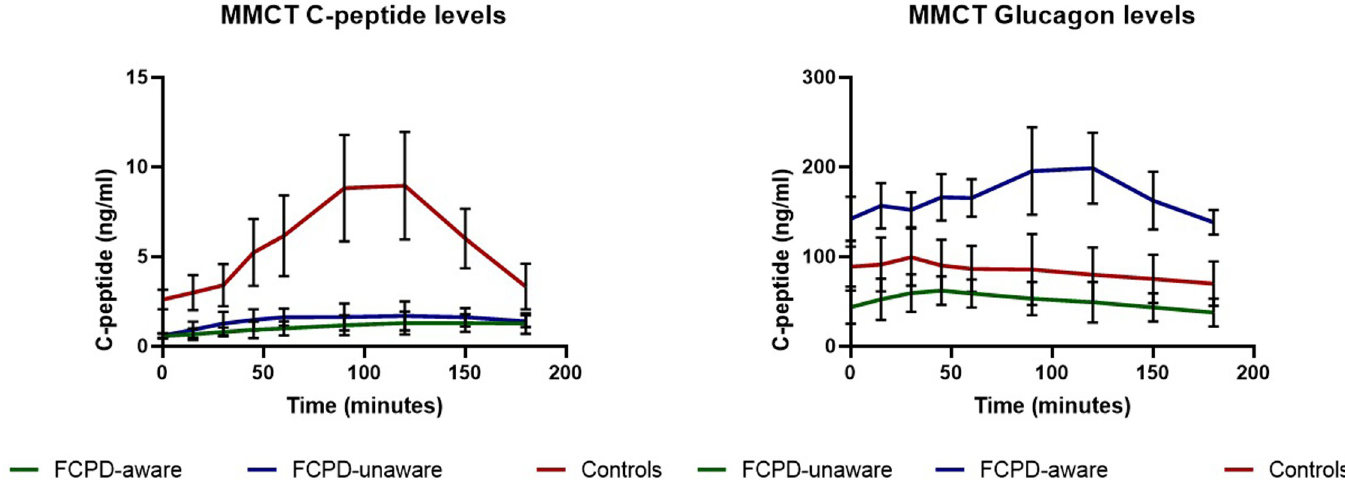
Fig 2. (a) . C-peptide levels in patients with FCPD and controls during MMCT. (b) . Glucagon levels in patients with FCPD and controls during